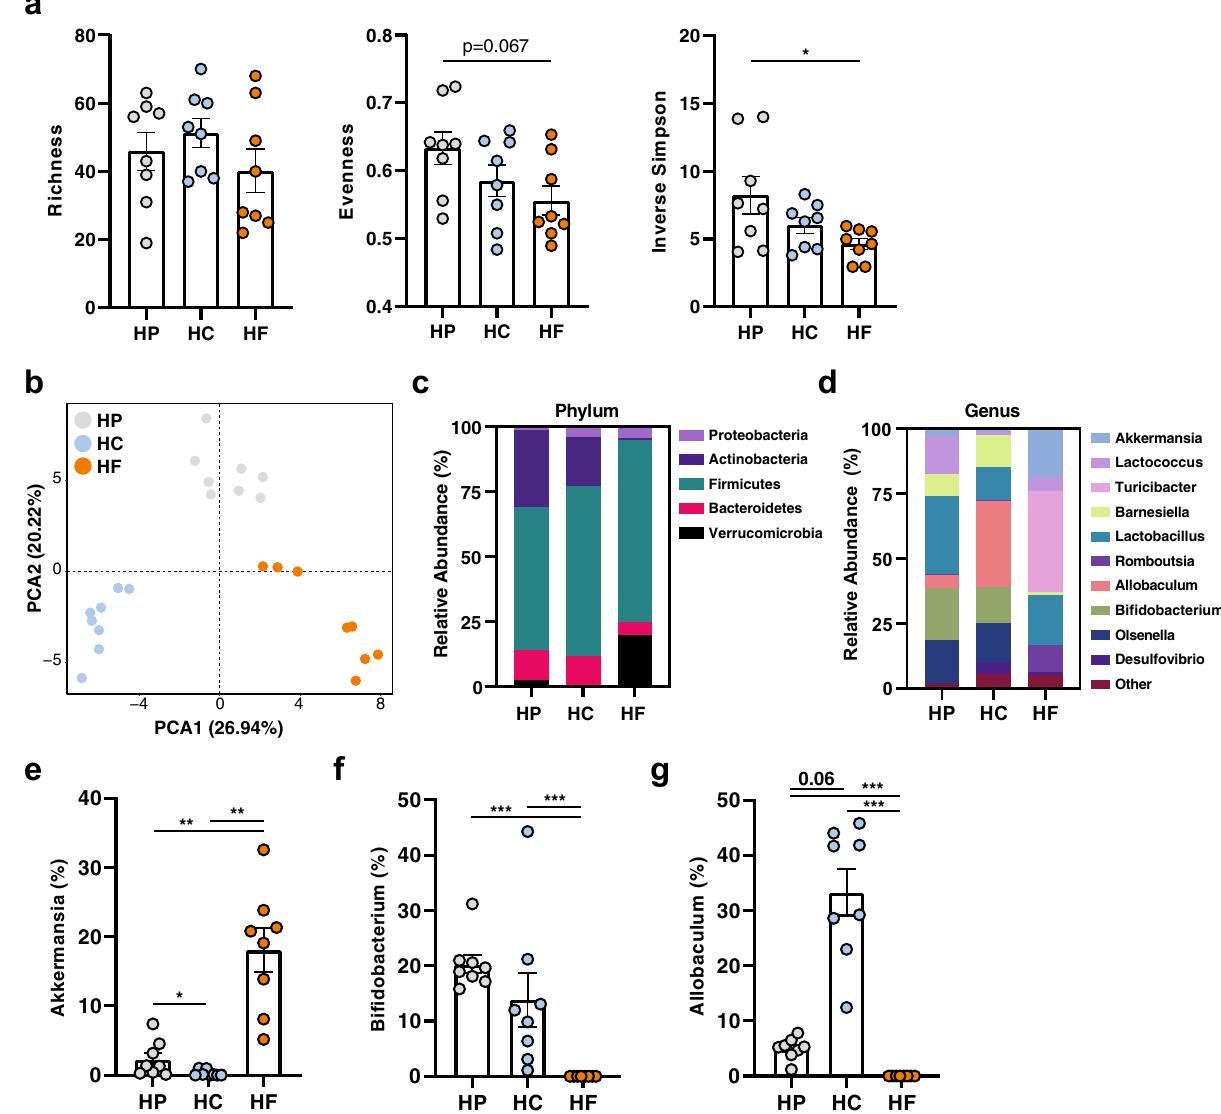
Fig. 4 Dietary intervention signi fi cantly affects the small intestine microbiota composition. Mice were fed on either a high-protein (HP), high- carbohydrate (HC), or high-fat (HF) diet for 6 weeks and DNA was extracted from small intestinal content for 16 S rRNA gene sequencing ( n = 8 mice per diet). Diversity of the small intestinal microbiome was determined by a Richness, Evenness and Inverse Simpson Index (HP vs. HF p = 0.0269) with * p < 0.05 by ordinary one-way ANOVA followed by Tukey ’ s multiple comparisons test. b Differences in the structure of the small intestinal microbiota communities were determined by principal component analysis (PCA) of Aitchison ’ s distance (Euclidean distance of centre-log transformed counts). Relative abundance of bacteria in the small intestine is represented at the c phylum and d genus level (showing only the top 10 genera). Relative abundance of ( e ) Akkermansia (HP vs. HC p = 0.032/ p = 0.013, HP vs. HF p = 0.002/ p = 0.003, HC vs. HF p = 0.002/ p = 0.003), f Bi fi dobacterium (HP vs. HF p = <0.0001/ p = 0.001, HC vs. HF p = <0.0001/ p = 0.001), and ( g ) Allobaculum (HP vs. HF p = <0.0001/ p = 0.001, HC vs. HF p = <0.0001/ p = 0.001) with, **<0.01, ***<0.001 by Aldex2 test (Welch ’ s t test/Wilcoxon test with Benjamini – Hochberg corrected false discovery rate). Data are represented as mean ±